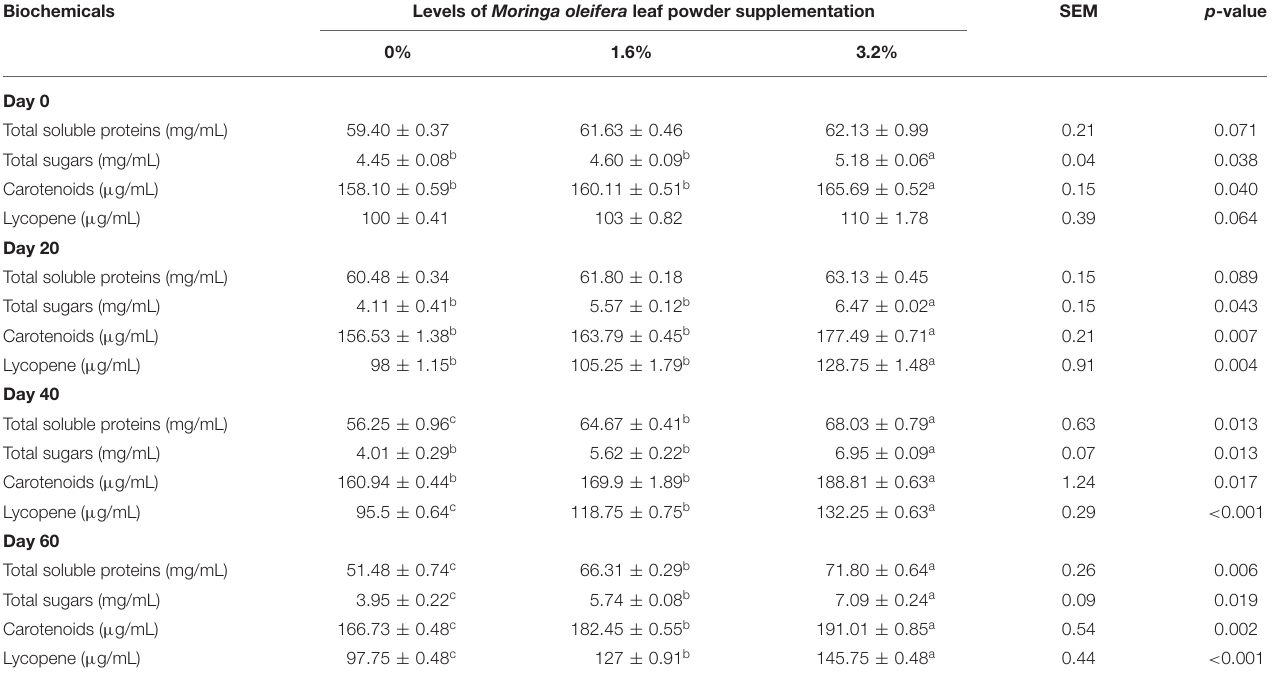
TABLE 6 | Plasma biochemical indices of pregnant beetal goats.